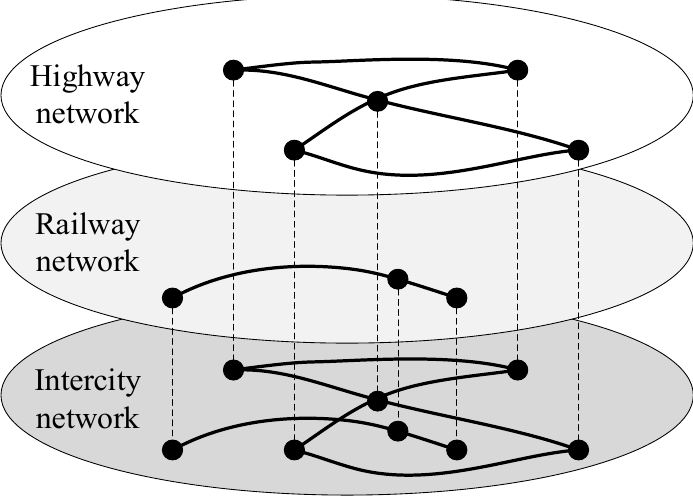
Figure 1. Schematic diagram of the intercity network.